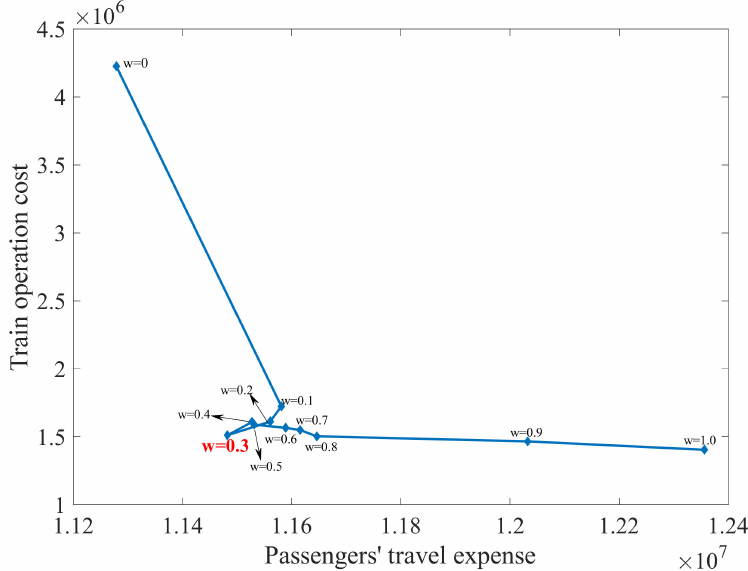
Figure 6. Graph of the sensitivity